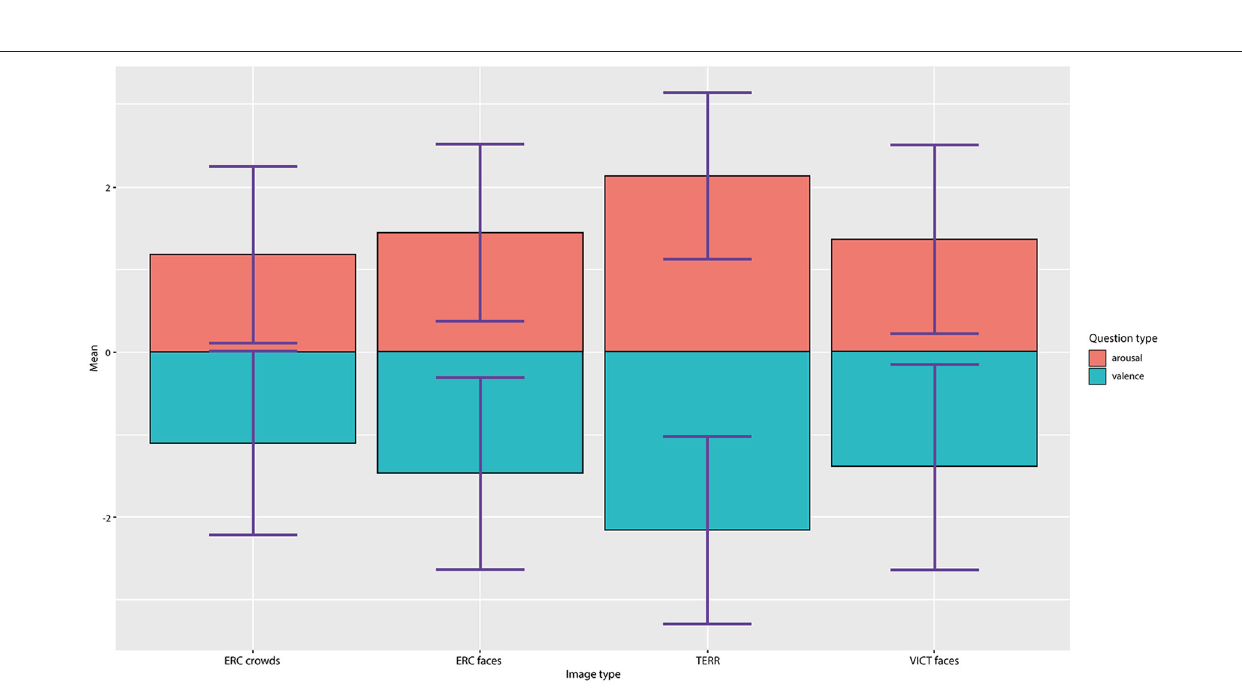
Frontiers in Behavioral Neuroscience |